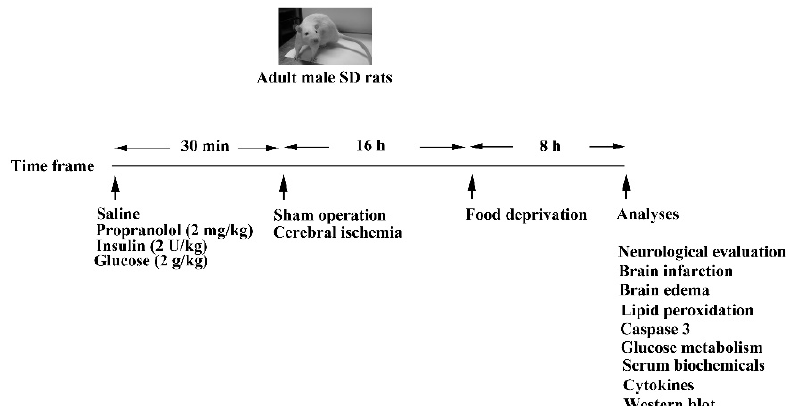
Figure 1. Schematic diagram of animal study design. Adult male Sprague-Dawley rats were